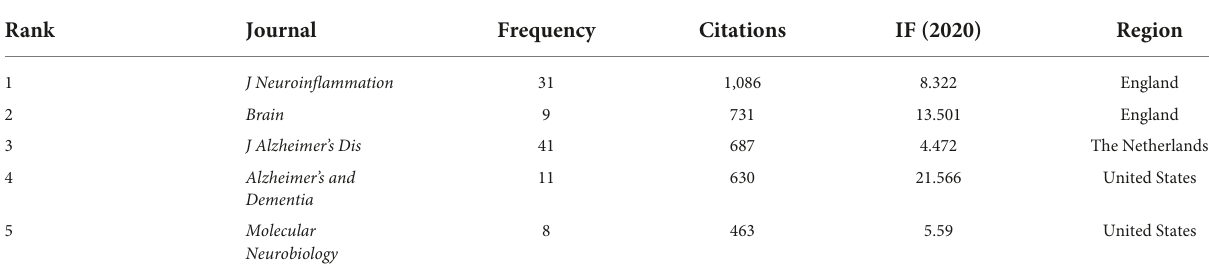
TABLE 3 Top five journals in terms of the number of